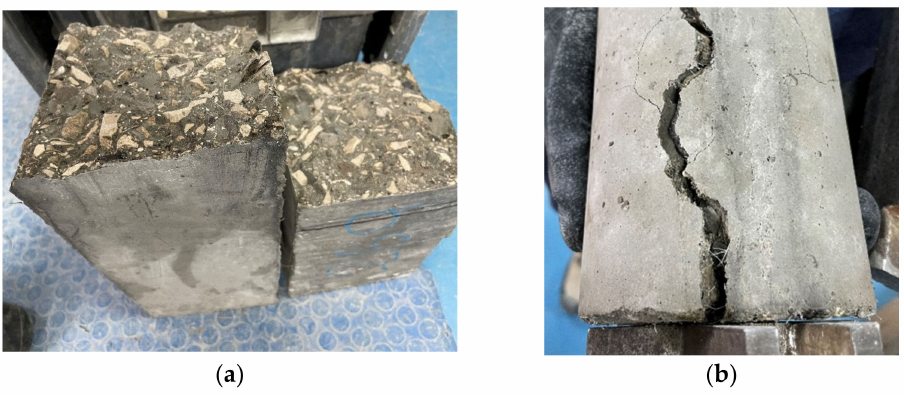
Figure 7. ( a ) Beam tested in flexure after failure; ( b ) Splitting tensile strength tested cylinder after load. The addition of natural sisal and polypropylene fibres improved the tensile strength depending on the amount of fibres (Figure